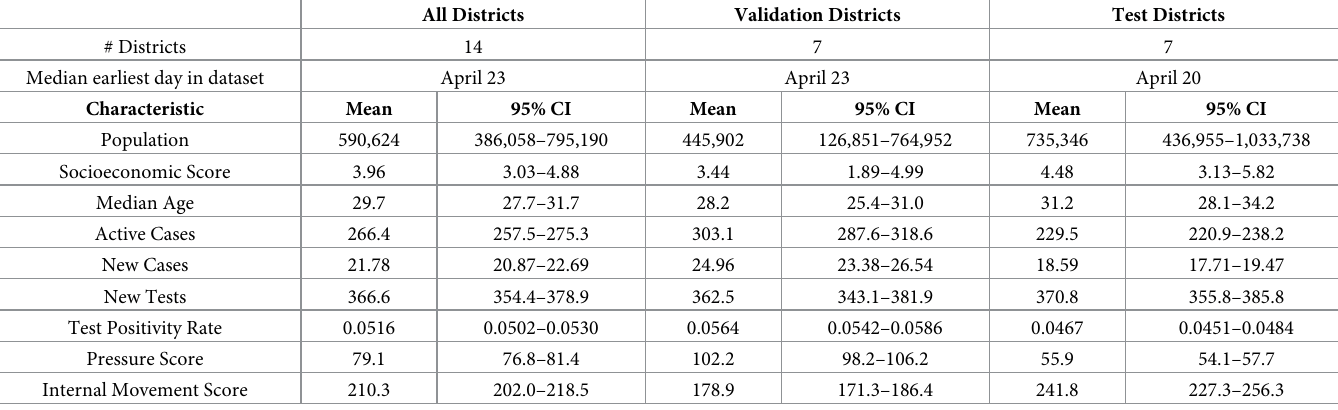
Table 2. Descriptive characteristics of the districts in our